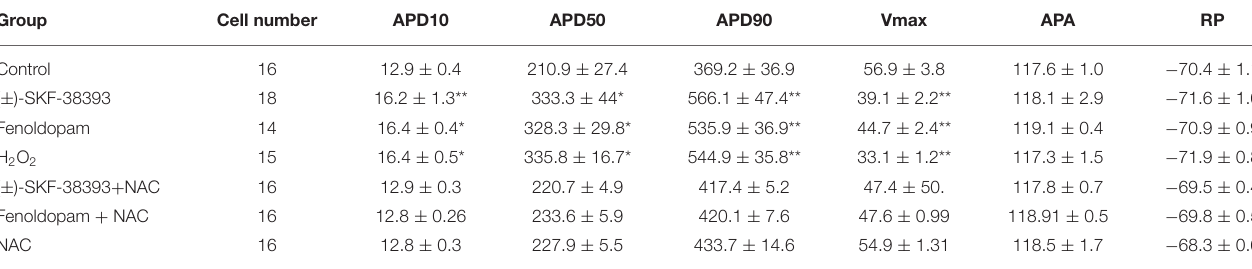
TABLE 2 | Analysis of action potentials influenced by ROS in presence of dopamine receptor